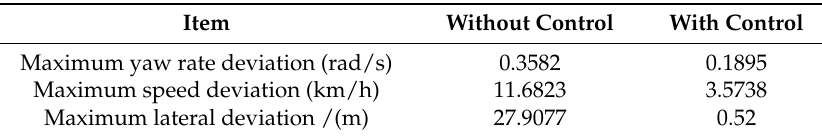
Figure 9. Experimental comparison with/without control under E3 condition. Table 12. Statistical control effect under E3 condition.